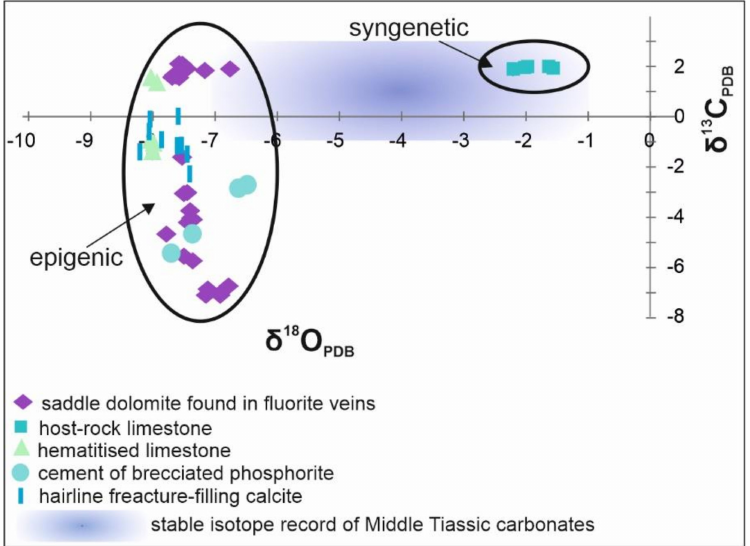
Figure 9. Stable isotope data of calcite grains from fluorite veins are similar to the carbon and oxygen isotopic compositions of the epigenetic calcite crystals found in phosphorite, suggesting their common, hydrothermal origin [2]. In the figure the range of Middle Triassic carbonates is also shown